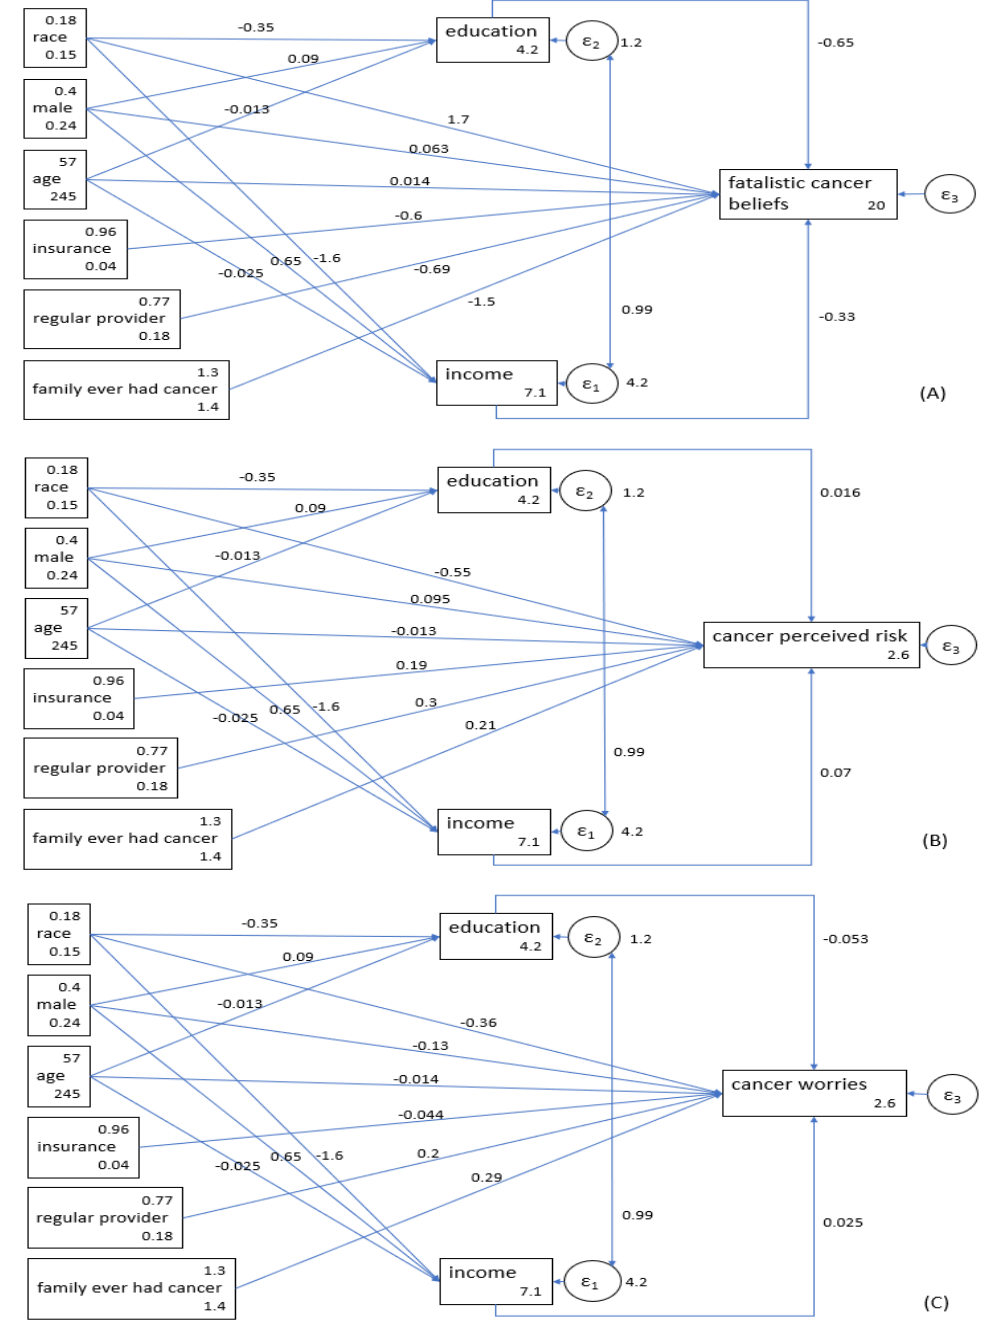
Figure 1. The associations between race, socioeconomic status (SES; educational attainment and income), and fatalistic cancer beliefs, perceived risk, and worries in a national sample of American adults. ( A ) Outcome: Fatalistic Cancer Beliefs. ( B ) Outcome: Cancer Perceived Risk. ( C ) Outcome: Cancer Worries.